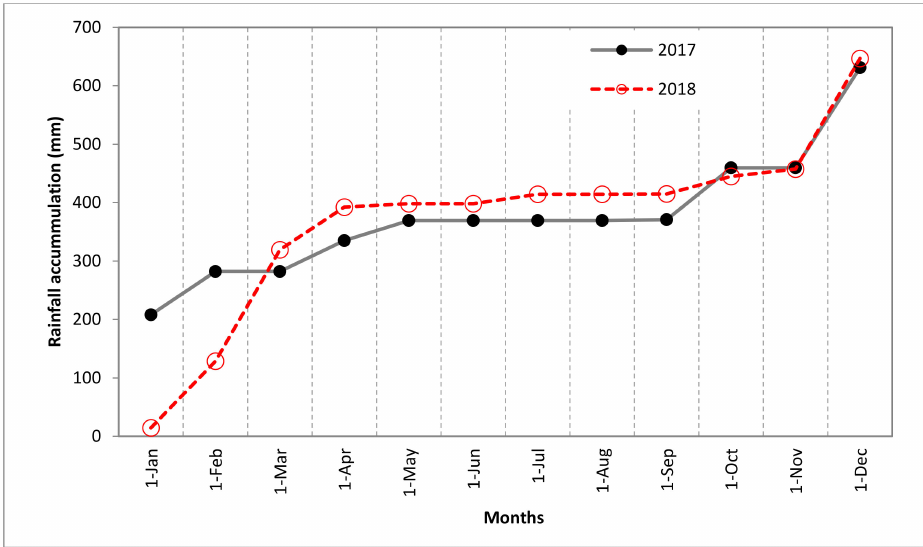
Figure 5. Comparison of rainfall accumulation between 2017 and